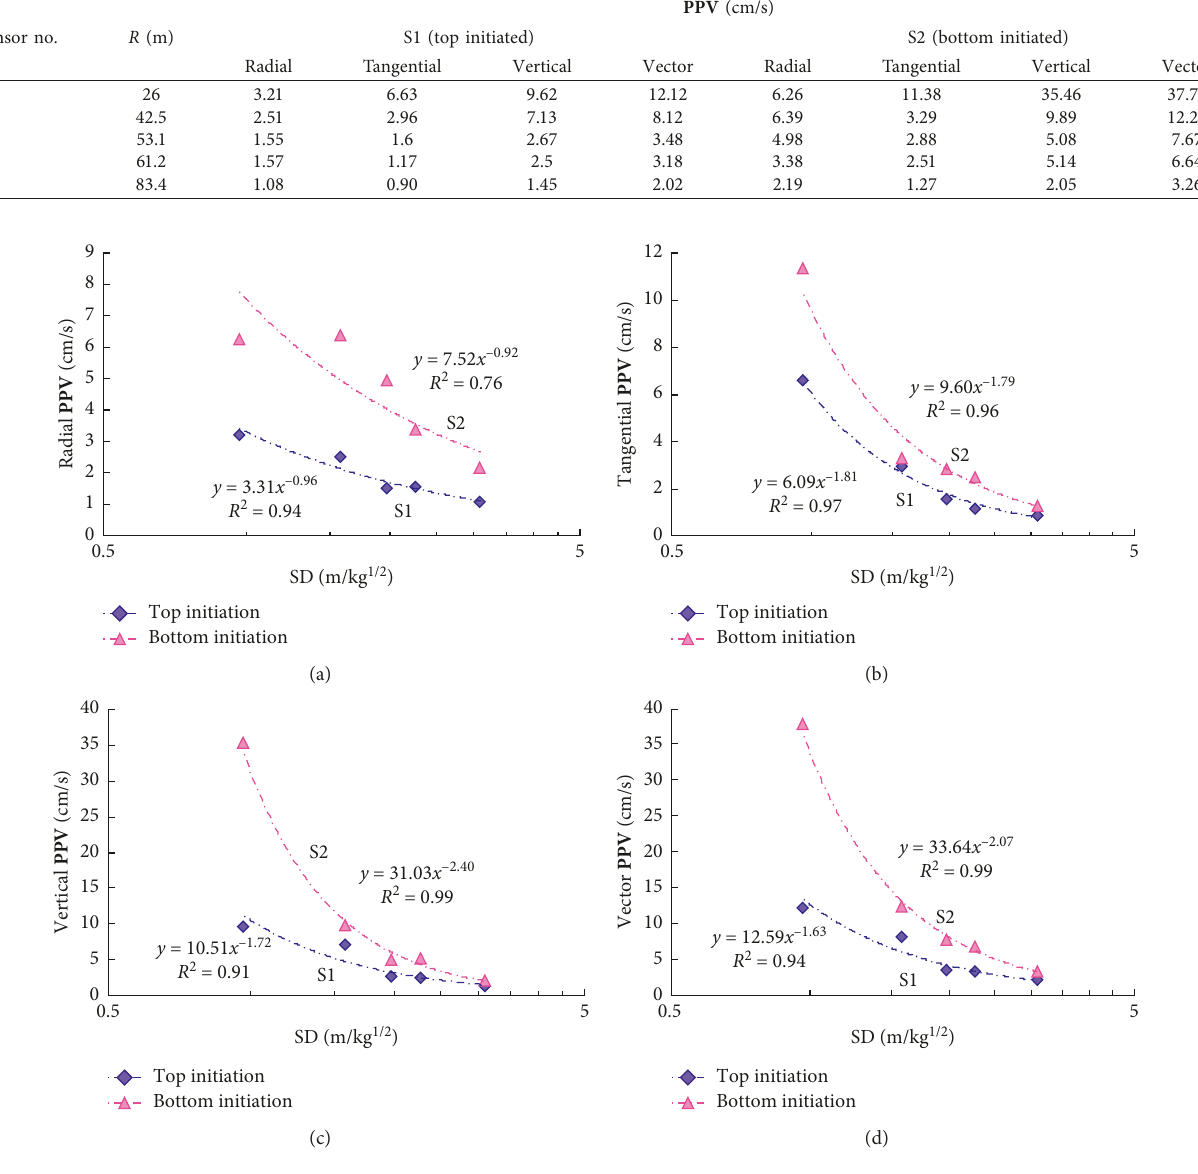
Figure 27: Fitted curves of the PPV against SD in the production blasting experiment. (a) Radial PPV . (b) Tangential PPV . (c) Vertical PPV . (d) Vector PPV .